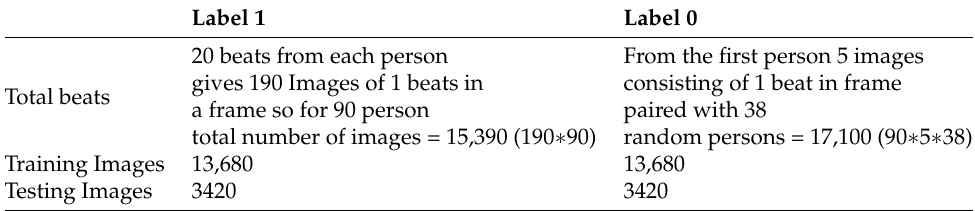
Table 3. Description of the number of training and testing patterns with a single beat as an image. Label